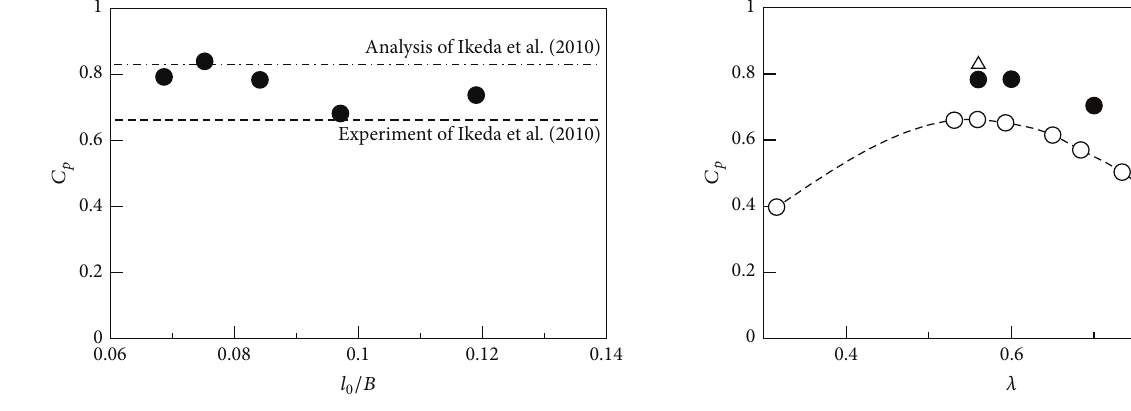
Figure 10: Change in power coefficient 𝐶 𝑝 due to distance between particles 𝑙 0 when 𝜆 = 0.56 .